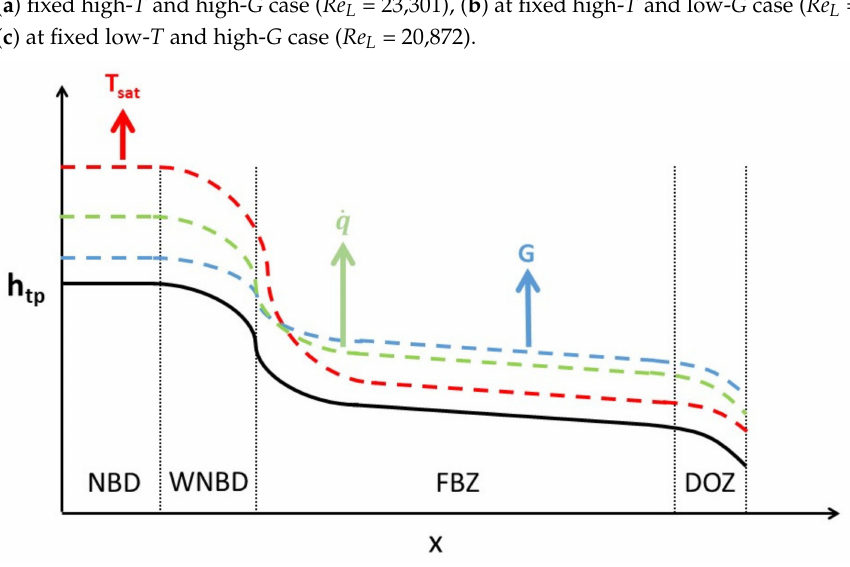
Figure 10. Representation of the effects of the varying experimental conditions on the heat transfer coefficients for the full vapor quality